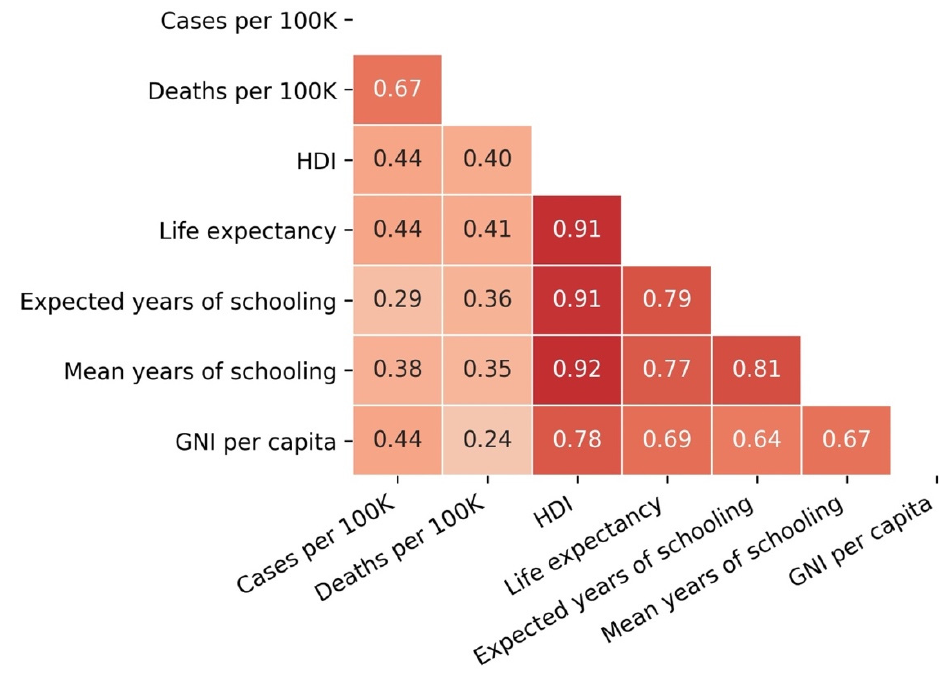
Figure 16. Cases vs. deaths: Matrix of Pearson correlation coefficients of total scaled values of cases and deaths with countries’ development metrics (HDI, Human Development Index; GNI, Gross National Income).